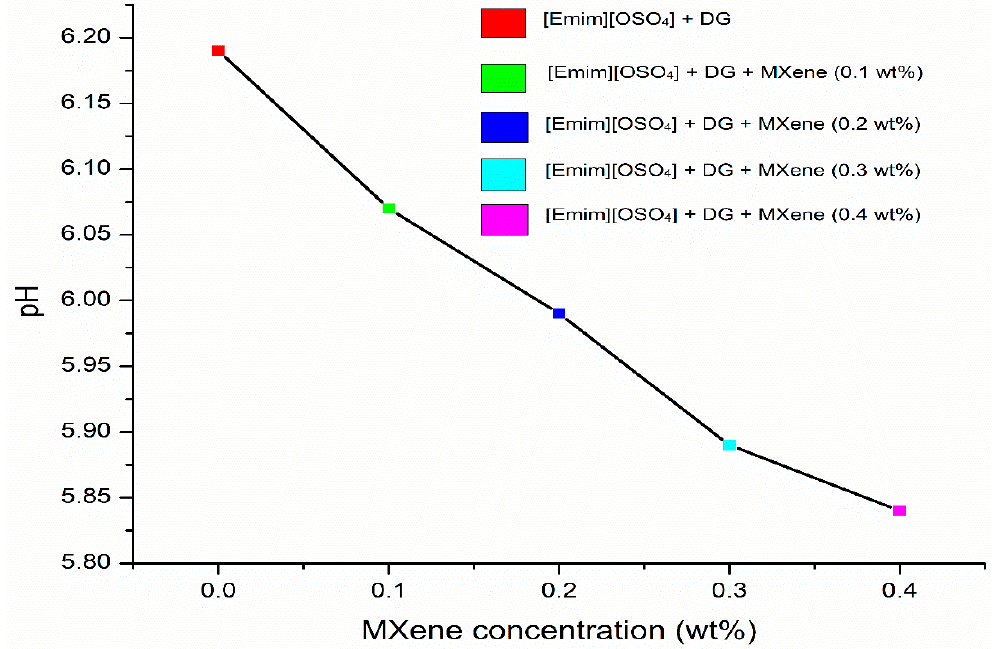
Figure 6. Variation of pH for different concentrations of Mxene nanoparticles.